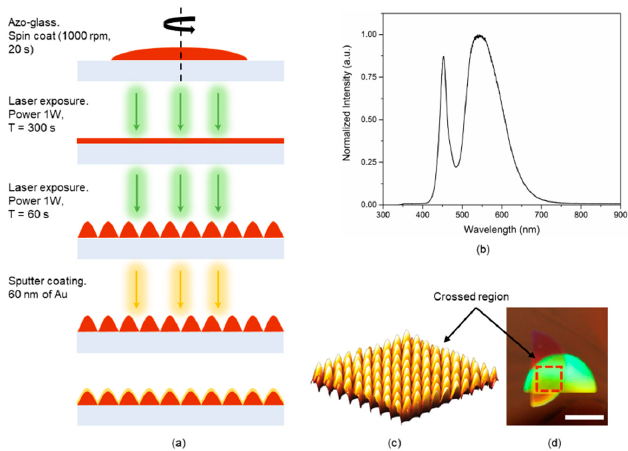
Figure 1. ( a ) Schematics of the fabrication procedure for Crossed Surface Relief Gratings (CSRGs). ( b ) Normalized spectra for white LED used in this work. ( c ) Atomic force microscopy (AFM) scan of 4 µm × 4 µm crossed region showing the orthogonally superimposed SRGs. ( d ) Actual image of the fabricated CSRGs with the crossed region marked with red box. White scale bar corresponds to 1 cm.